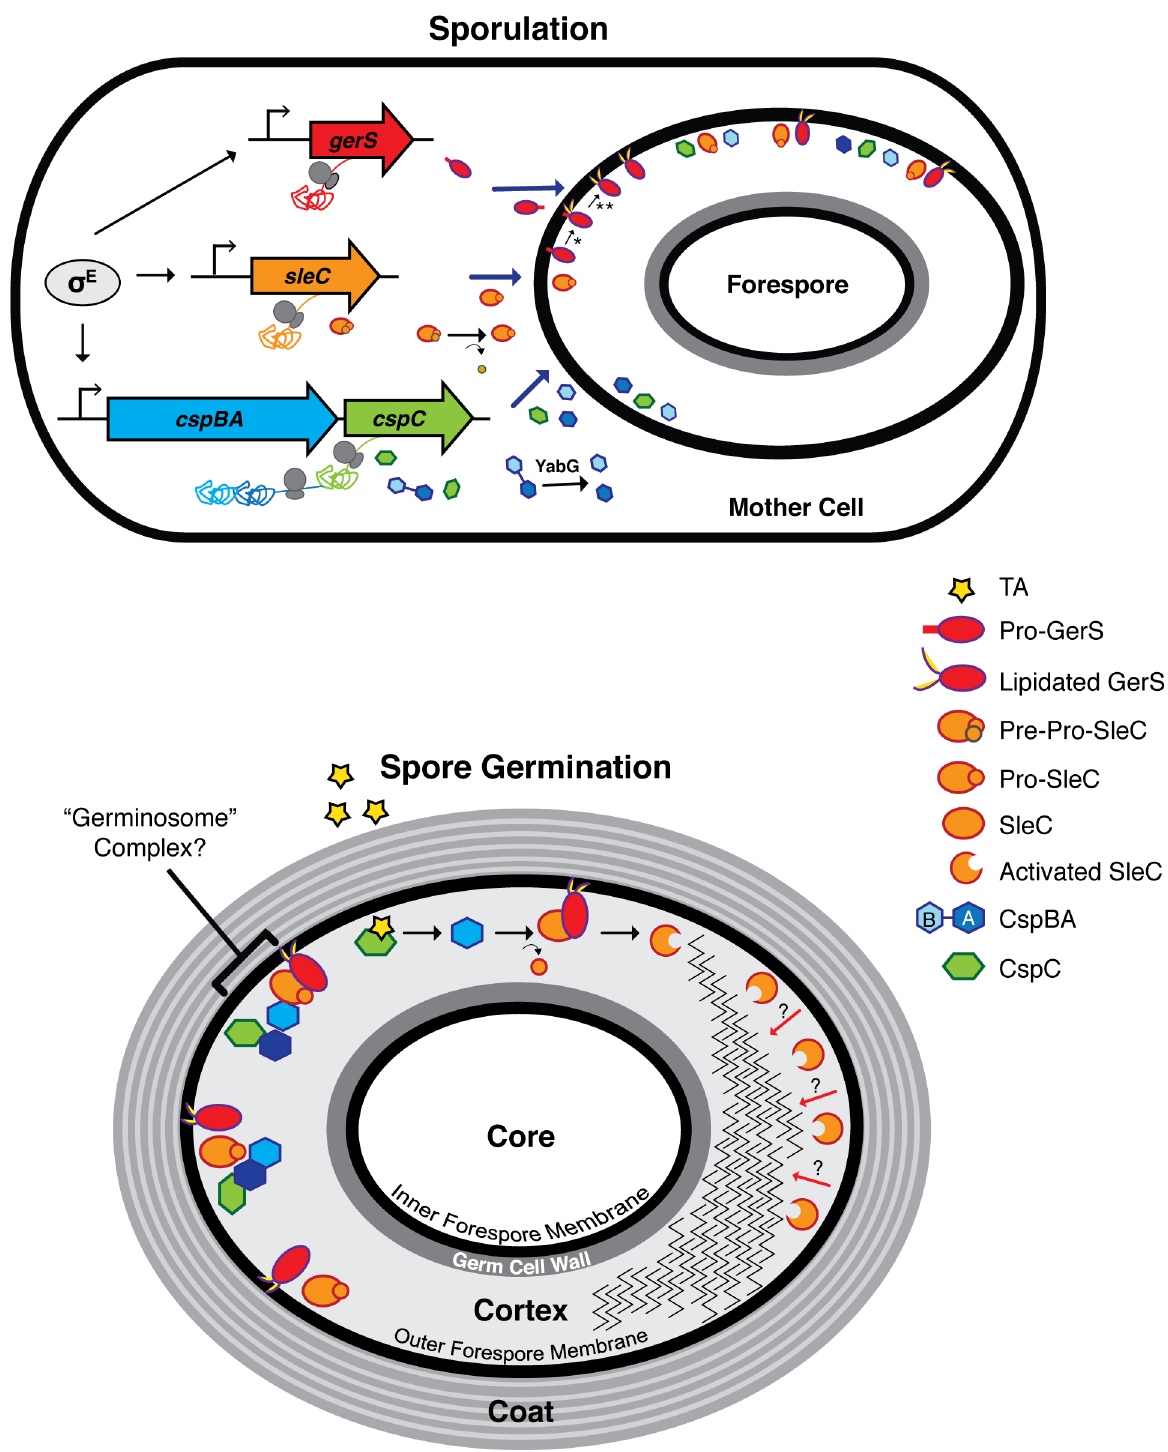
Fig 9. Model of C . difficile germination regulator production and localization during sporulation and germination. The sporulating cell depicts transcription of germination regulator genes and translation of the resulting transcripts. gerS , sleC , and cspBAC are all controlled by σ E in the mother cell. σ G may regulate the expression of gene products involved in germination, but these are unknown. In the mother cell, removal of the pre-domain is depicted by the curved arrow, while interdomain cleavage of CspBA is demarcated by the red X; these processing events occur during spore maturation [23]. Solid blue arrows designate transport of proteins from the mother cell into the forespore compartment. In mature spores, the germination regulators, GerS, SleC,